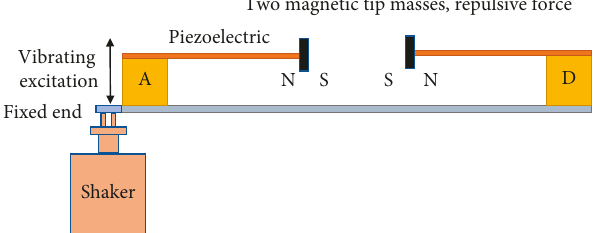
Figure 1: Schematic diagram of the nonlinear and EMM